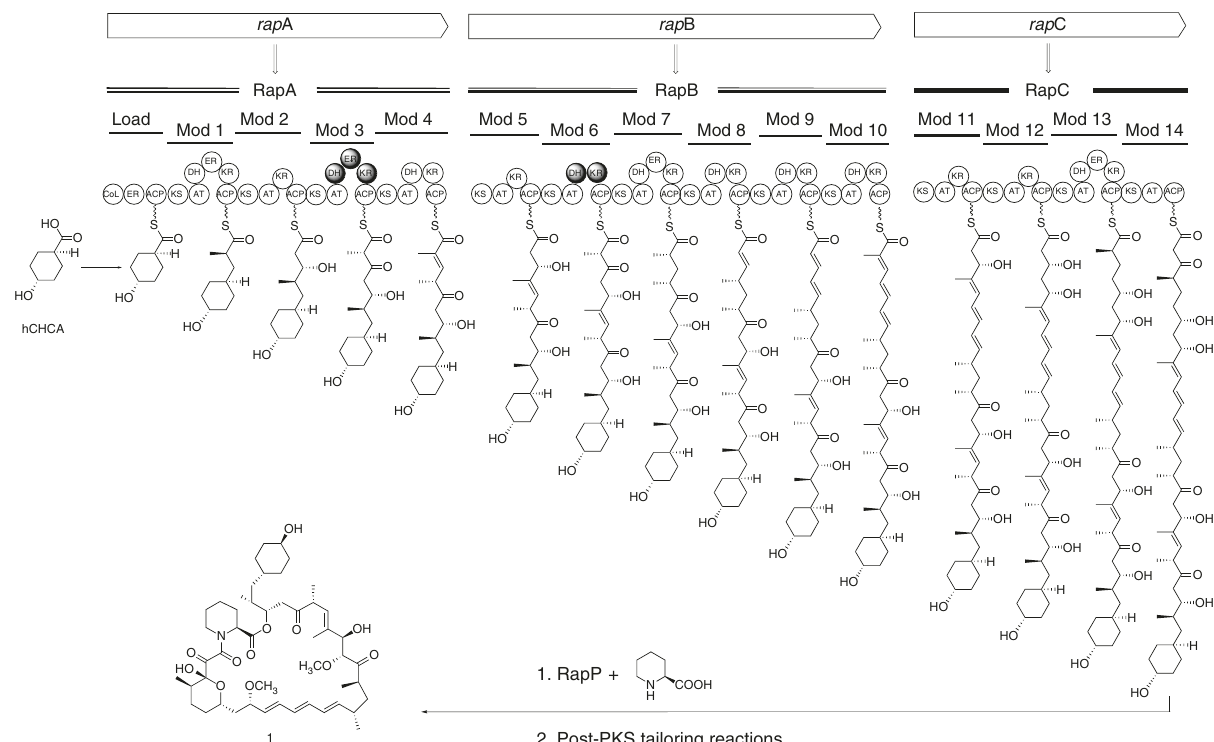
Fig. 1 Pathway for the biosynthesis of 1 and organisation of the rapamycin PKS. The repetitive, modular nature of each PKS protein is clearly evident. The circles represent individual catalytic domains: CoL = CoA ligase like; KS = β -ketoacyl-ACP synthase; AT = acyltransferase; DH = dehydratase; ER = enoyl reductase; KR = β -ketoacyl-ACP reductase; ACP = acylcarrier protein. Filled circles represent inactive domains. hCHCA = trans -4- hydroxycyclohexanecarboxylic acid which is fed to the strain ISOM-4010 to initiate the biosynthesis of 1 and rapalogs 2 – 8 NATURE COMMUNICATIONS | 8: 1206 | DOI: 10.1038/s41467-017-01344-3 |